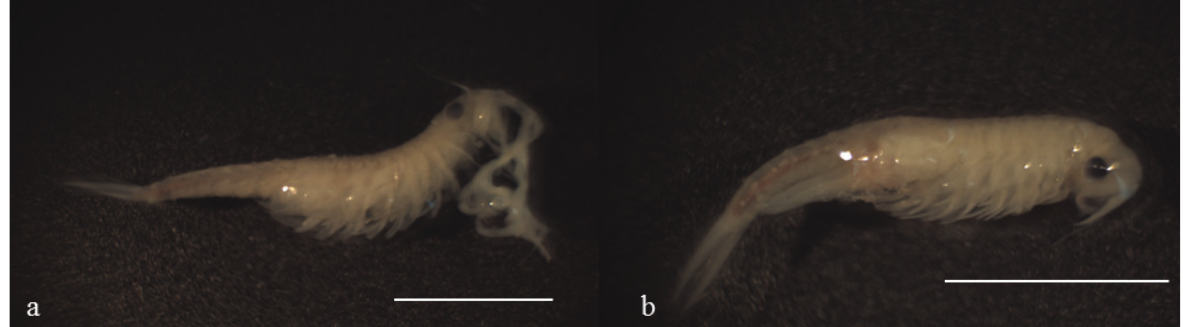
Figure 2 - Specimens of Dendrocephalus brasiliensis collected from Carás River basin, Juazeiro do Norte, Ceará, Brazil. (a) male; (b) female. ; Scale: 0.5